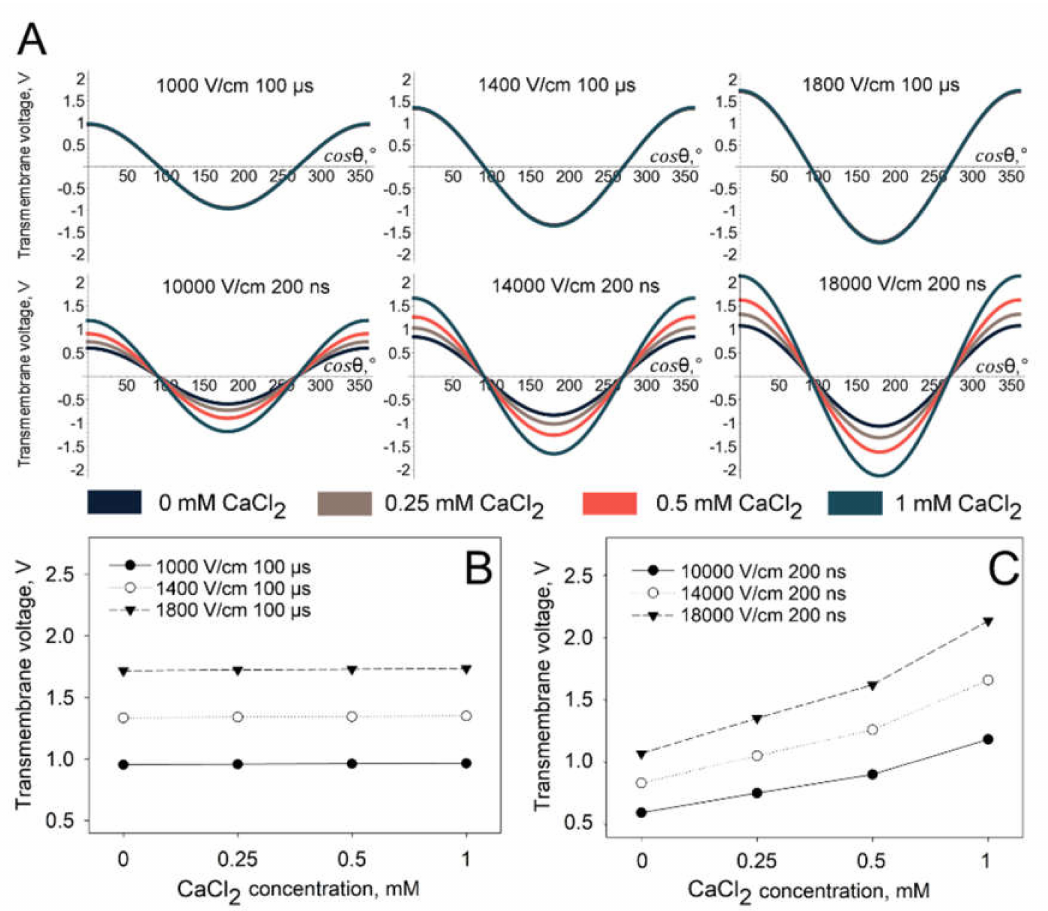
Figure 8. Modelling of transmembrane potential distribution on cell surface ( A ) and the peak transmembrane potential at the electrode-facing poles after microsecond ( B ) and nanosecond ( C ) electric pulse